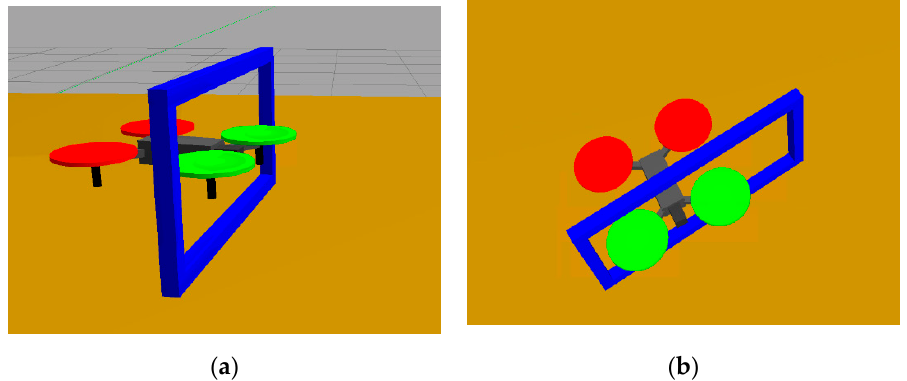
Figure 1. Drone simulator developed in Gazebo. Two shots taken from different points of view at the moment the quadcopter goes through the blue frame: ( a ) lateral view; ( b ) top view.